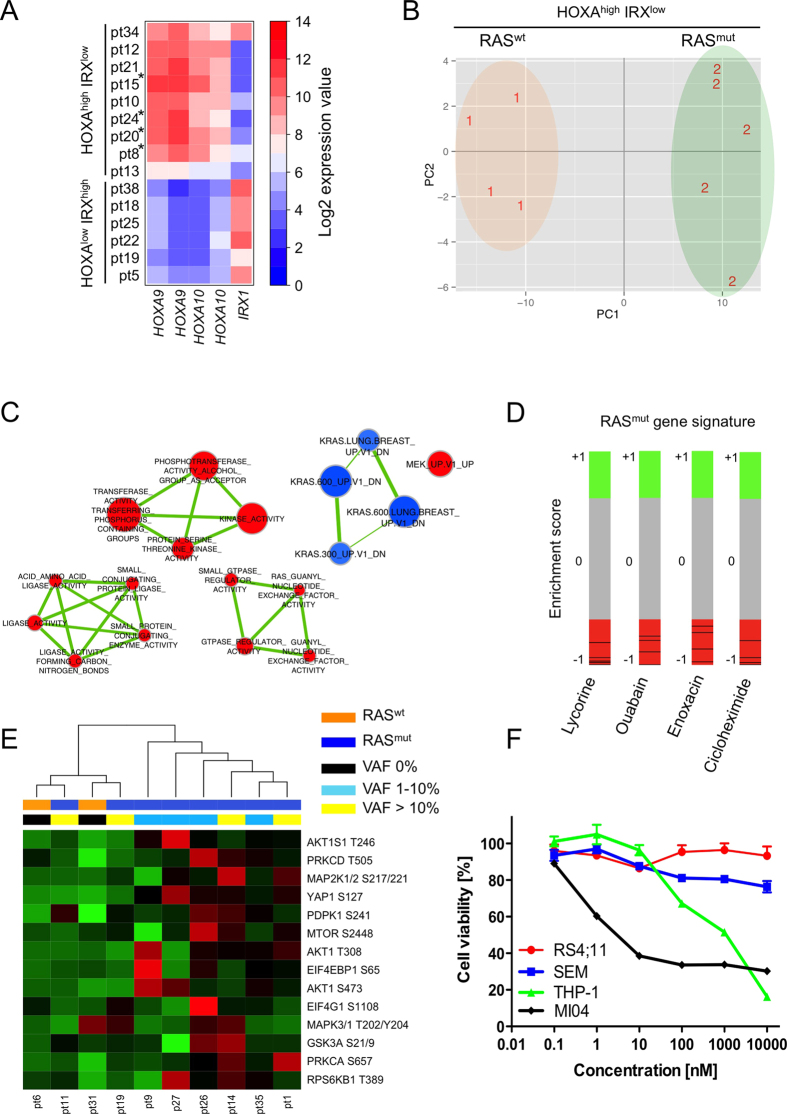
Detection of a RAS related signature in RASmut patients.(A)
HOXA9 (209905_at and 214651_s_at), HOXA10 (213150_at and 213147_at) and IRX1 (230472_at) expression levels in 15 MLL-AF4 positive patients at diagnosis. *: RAS wild type (RASwt) patients. (B) Principal component analysis (PCA) of HOXAhighIRXlow/RASmut and HOXAhighIRXlow/RASwt patients. The samples were projected into a 2-dimensional space (PC1 and PC2) consisting of the differentially expressed genes (FDR q-val < 0.05) between HOXAhighIRXlow/RASmut (N = 5; label: 2) and HOXAhighIRXlow/RASwt (N = 4; label: 1) patients. Samples with similar characteristics will cluster together. (C) Enrichment map visualization of significant (FDR q-val < 0.05) enriched gene sets comparing HOXAhighIRXlow/RASmut and HOXAhighIRXlow/RASwt patients. Gene sets are depicted as circles (nodes) with edges indicating overlap between nodes. Node size is proportional to gene set size and the edges thickness shows the degree of overlap among the nodes. Red and blue colours indicate positive and negative enrichment in HOXAhighIRXlow/RASmut samples, respectively. (D) Bar-views according to connectivity map analysis. Each black line represents an individual treatment instance ordered according to its corresponding connectivity score (+1 and −1) with respect to the query signature based on genes differentially expressed between HOXAhighIRXlow/RASmut and HOXAhighIRXlow/RASwt patients with FDR q-val < 0.1. Instances at the bottom (connectivity score: −1) are more strongly anti-correlated with the query signature indicating the possibility to revert the RASmut phenotype. (E) The hierarchical clustering analysis of RASmut (N = 8) and RASwt (N = 2) patients samples according to proteins levels measured by RPPA reveals two clusters. One cluster contains all but 2 RASmut patients and the second one contains the 2 RASwt and the remaining 2 RASmut patients. Rows represent each analysed protein and columns represent patients. The red and green colours reflect high and low expression level, respectively. (F) MTT cell viability assay in the MLL-AF4+ RASmut cell line MI04 and in two RASwt MLL-AF4+ cell lines (i.e. RS4; 11 and SEM) treated for 72 h with increasing concentration of PD0325901. The myeloid cell line THP-1 with the NRAS G12D and the MLL-AF9 fusion gene was use as positive control. Data represent mean values ± s.d. of three independent experiments.